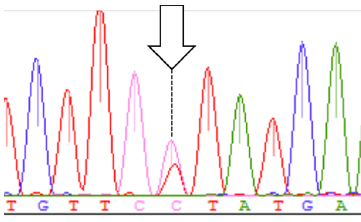
Figure 1. The signal of the heteroplasmic mutation site. Table 2. Nucleotide (single nucleotide mutation or heteroplasmic change) and amino acid changes in the ND1 gene.